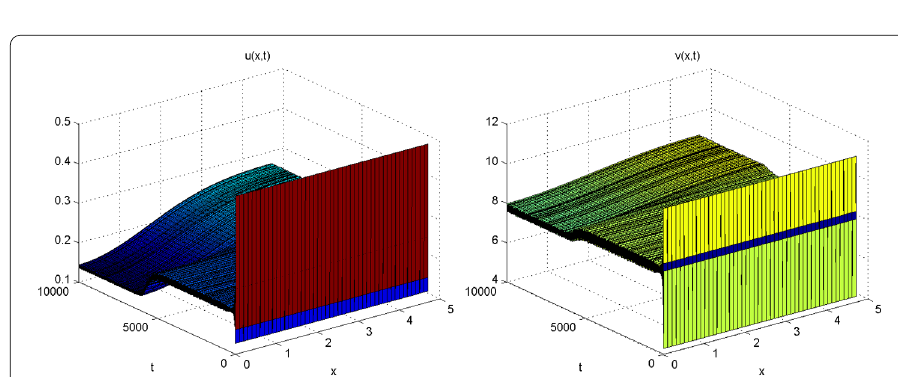
Figure 2 For system (4.1), s = 15 and the initial condition is (0.5,8.2). Left component: u ( x , t ) (Turing unstable). Right component: v ( x , t ) (Turing